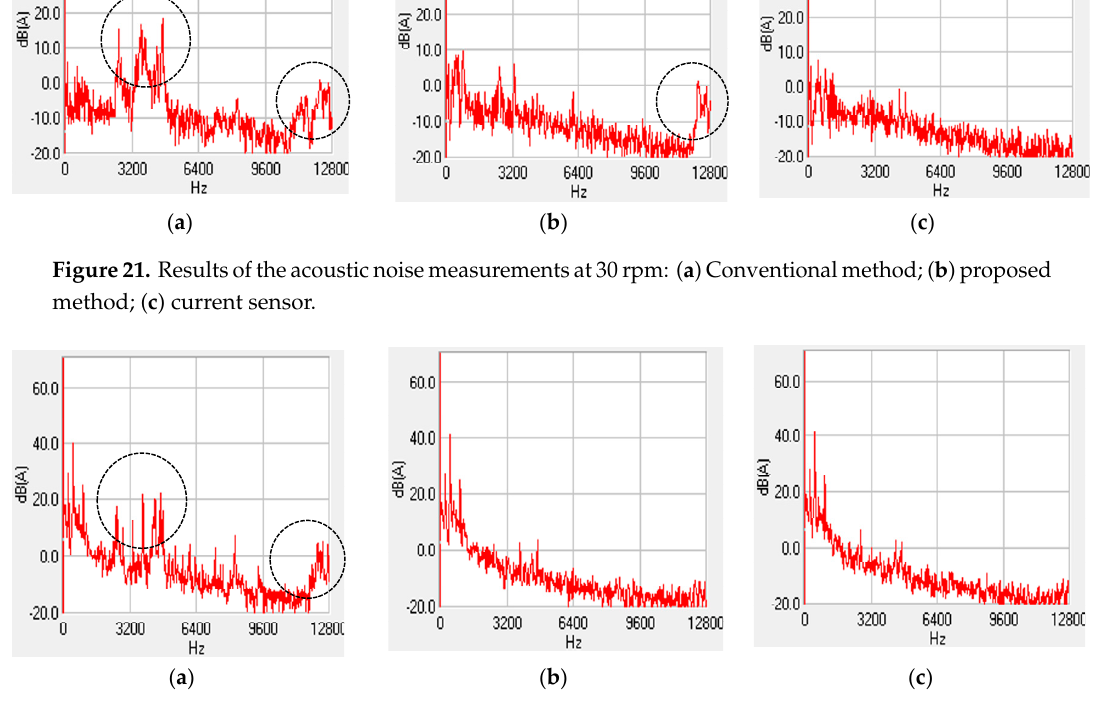
Figure 22. Results of the acoustic noise measurements at 400 rpm: ( a ) Conventional method; ( b ) proposed method; ( c ) current sensor.